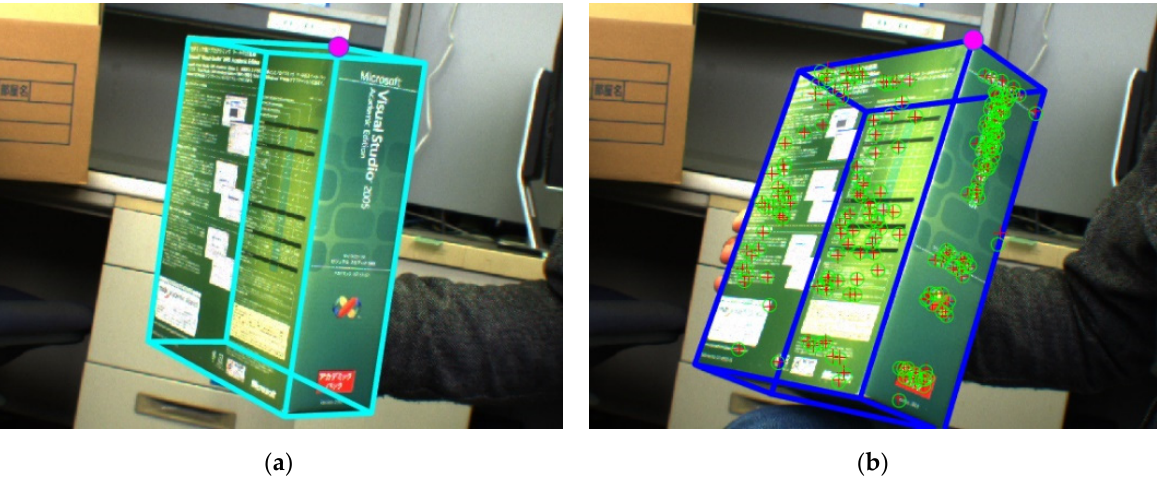
Figure 7. The visual result of our proposed algorithm on the 3D box dataset. ( a ) is the reference image, and ( b ) is the current image augmented by the reprojected contour. The red cross marks are the feature points matched with the reference image, and the green circle marks are the repro- jected features points using the determined camera pose. features points using the determined camera Table 1. The reprojection errors using the 3D box dataset.